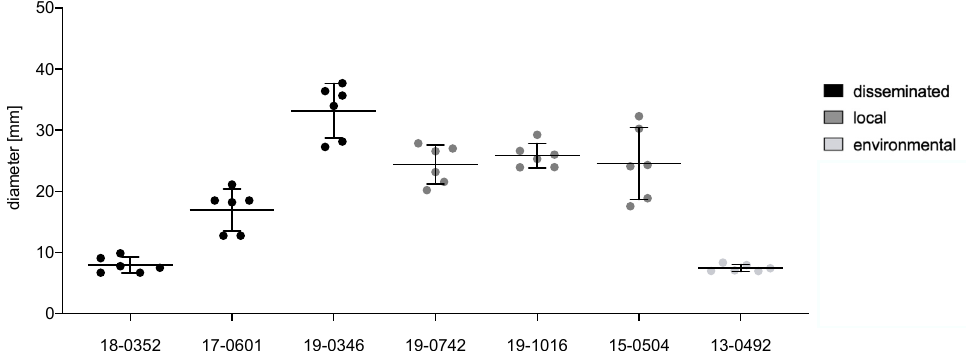
Figure 3. Urease activity of Cryptococcus neoformans var. neoformans isolates from disseminated infections (black), localized soft tissue infections (grey), and the environment (light grey). A total of 5 µL containing 10 6 cells were spotted on Christensen’s urea agar and incubated at 30 °C for 48 h. Halos surrounding colonies were measured digitally. Black lines show means with standard deviation of three biological replicates with two measurements each.